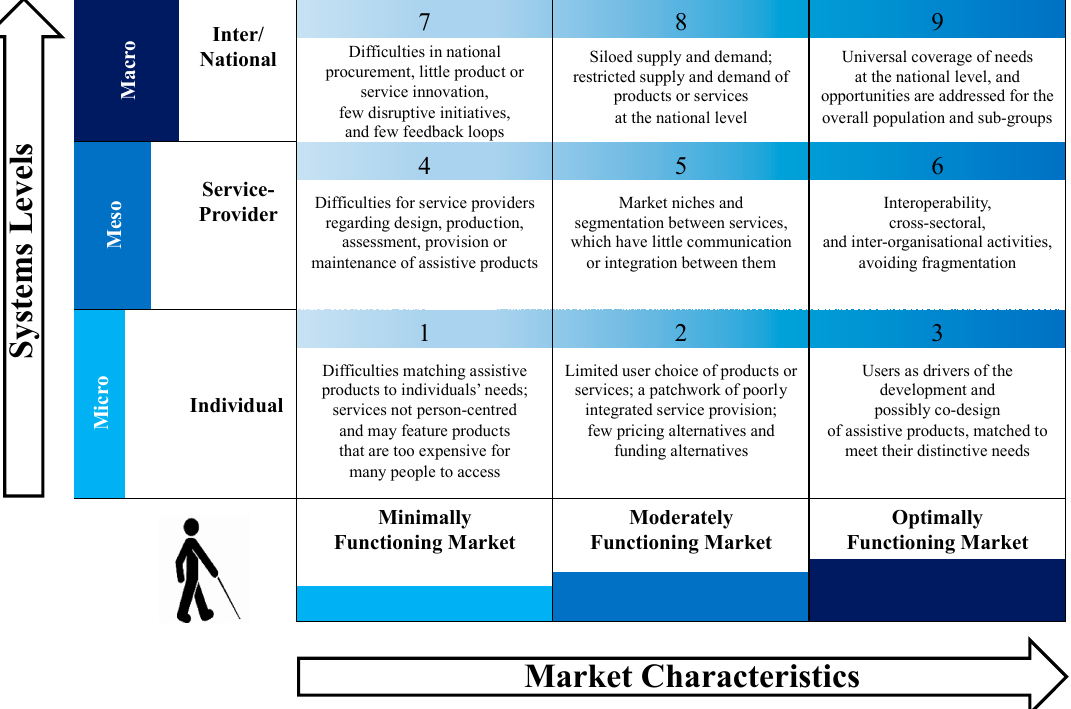
Figure 2. The SMART Thinking Matrix: A matrix showing intersections between systems levels and market characteristics for assistive and related technologies; as supported by research evidence cited in Appendix 1. Supplementary